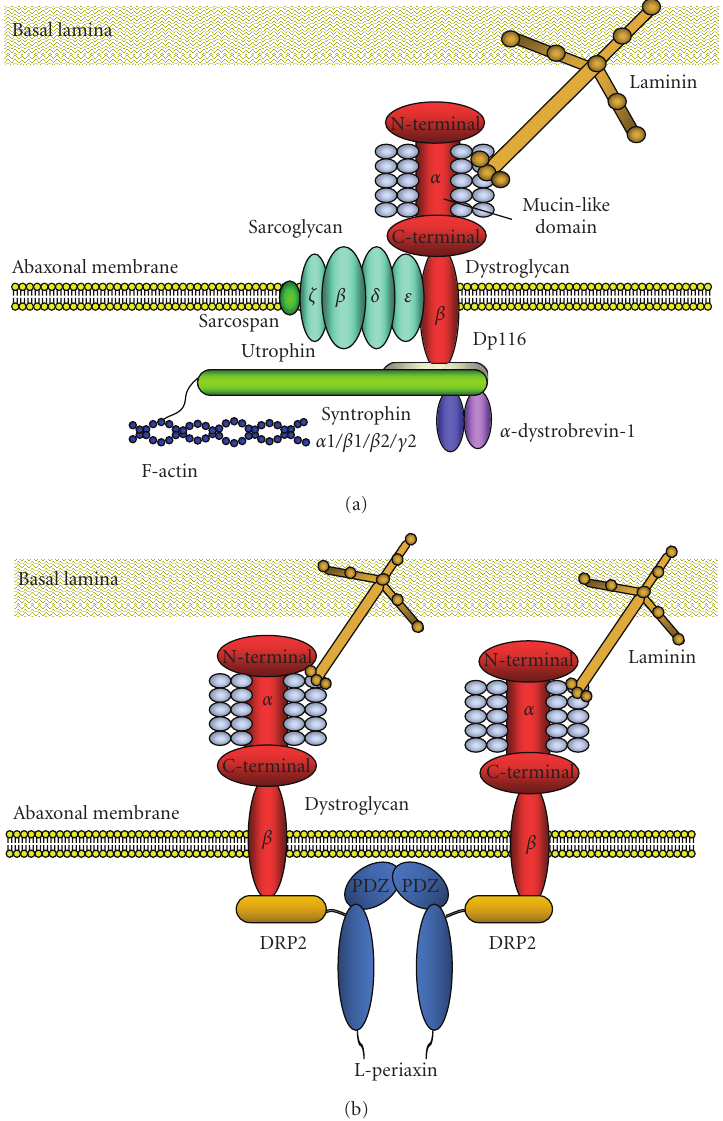
Figure 1: (a) Molecular structure of DGC (traditional type), present in Cajal cytoplasmic band of myelinated Schwann cells. a- and b- dystroglycan form membrane-spanning complex in Schwann cell abaxonal membrane. Mucin-like domain of a-dystroglycan is involved in the interaction with laminin via laminin G-like domains. a-dystroglycan is noncovalently anchored to b-dystroglycan. The cytoplasmic tail of b-dystrogylcan is anchored to the cytoskeletal proteins, Dp116, Schwann cell-specific isoform of dystrophin, or utrophin, an autosomal homolog of dystrophin. Utrophin interact with f-actin at the N-teminus. Utrophin or Dp116 interacts with syntrophins (a1, b1, b2, g2) and a-dystrobrevin-1. Also at least four isoforms of sarcoglycan (b, d, e, z) form sarcoglycan complex in abaxonal membrane and interact with dystroglycan complex. Sarcospan is supposed to interact with sarcoglycan complex. Thus DGC provides the physical link between extracellular matrix and submembranous cytoskeleton in Schwann cells. (b) Molecular framework of DGC present in membrane portion directly apposed to myelin sheath (DRP2/periaxin rich plaque) of myelinated Schwann cells. In DRP2/periaxin rich plaques, dystroglycan complex intracellularly interact with DRP2, third member of dystrophin family, and periaxin, homodimeric PDZ domain-containing protein, via cytoplasmic domain of b-dystroglycan. This type of DGC lacks syntrophins and